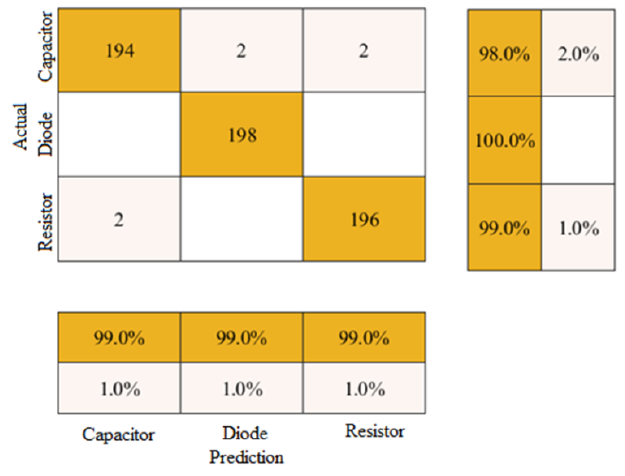
Figure 9. Proposed CNN model complexity matrix.